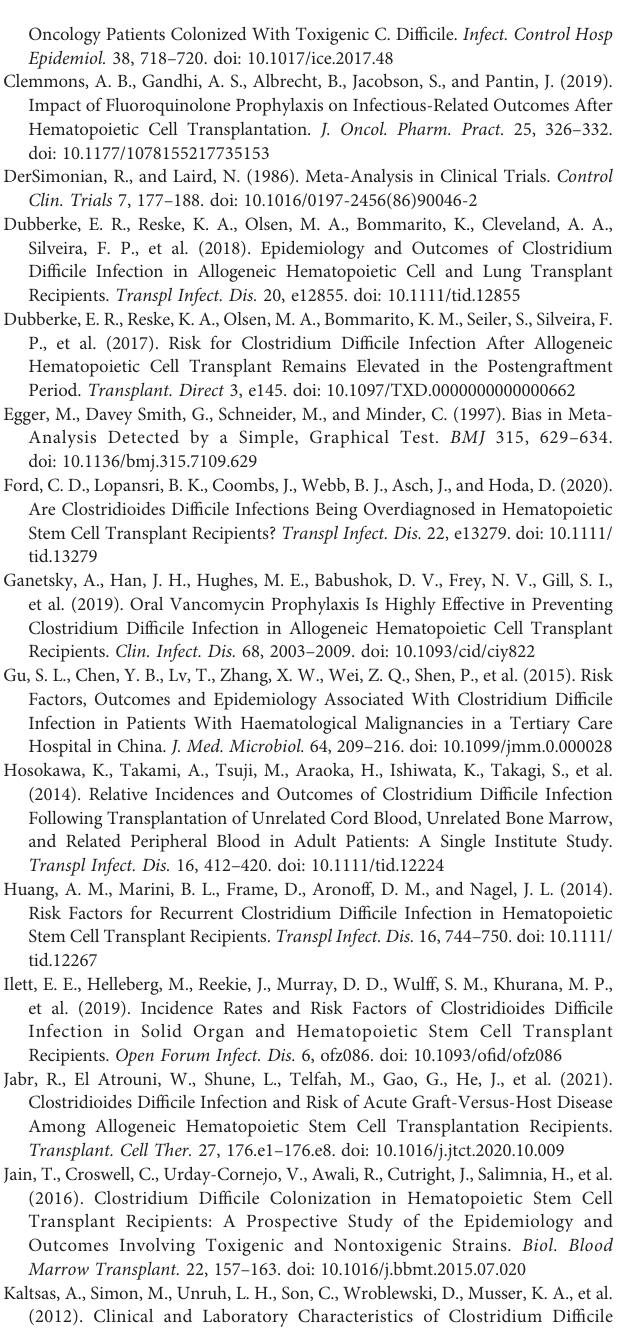
Supplementary Figure 6 | Prevalence of CDI surveyed in the Early term (A) , Middle term (B) , and Long term (C) . Supplementary Figure 7 | Prevalence of CDI in studies with EIA used only (A) , EIA + PCR/CC (B) , and PCR used only (C) . Supplementary Figure 8 | Prevalence of recurrent CDI in